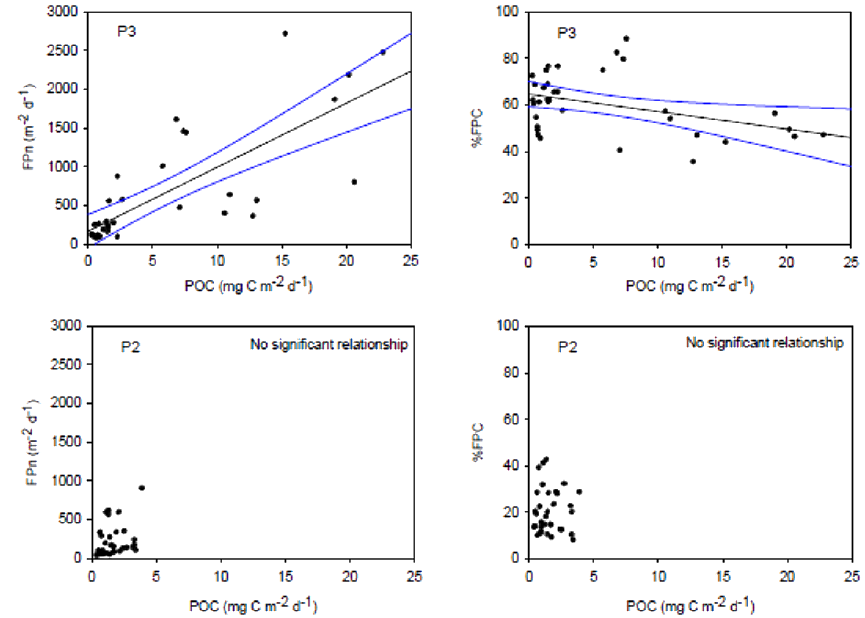
Figure 6. Relationship between POC (mgCm − 2 d − 1 ) and FPn (m − 2 d − 1 , left), on the one hand, and %FPC (right), on the other hand, for P2 and P3. Solid lines show fitted regressions with 95% confidence